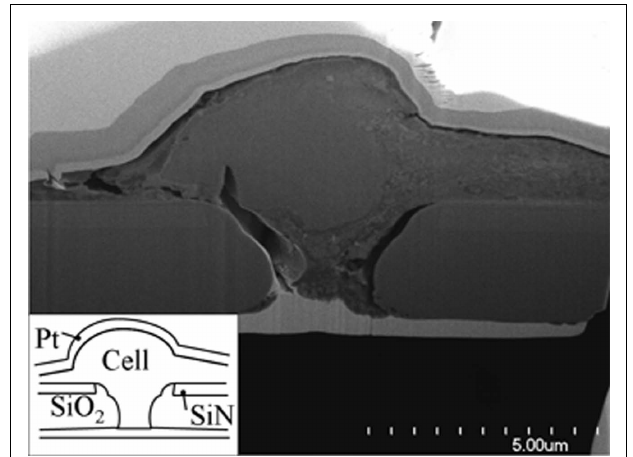
FIGURE 3 | Scanning Electron Micrograph of a focused ion beam section of a cultured P19 cell over an aperture in a SiN/SiO 2 stack membrane (see insert). To avoid damage during sectioning, the assembly is sandwiched between two platinum (light gray) layers.While somewhat damaged during fixing, the cell visibly lowers into the rounded conical aperture. Adapted from Py et al.